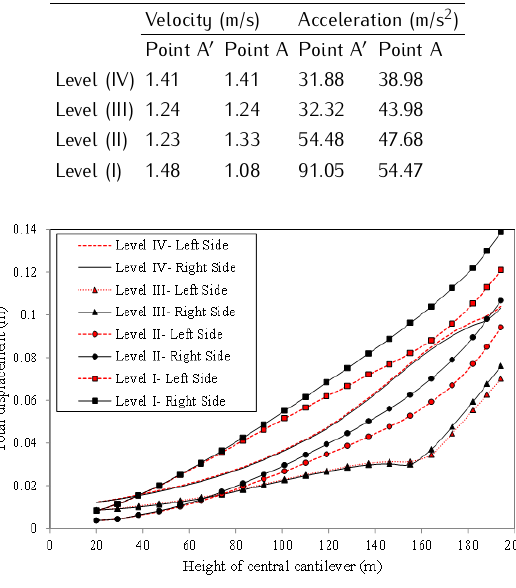
Table 6. Maximum velocities and accelerations at the crest points in stream direction; NL-DCM